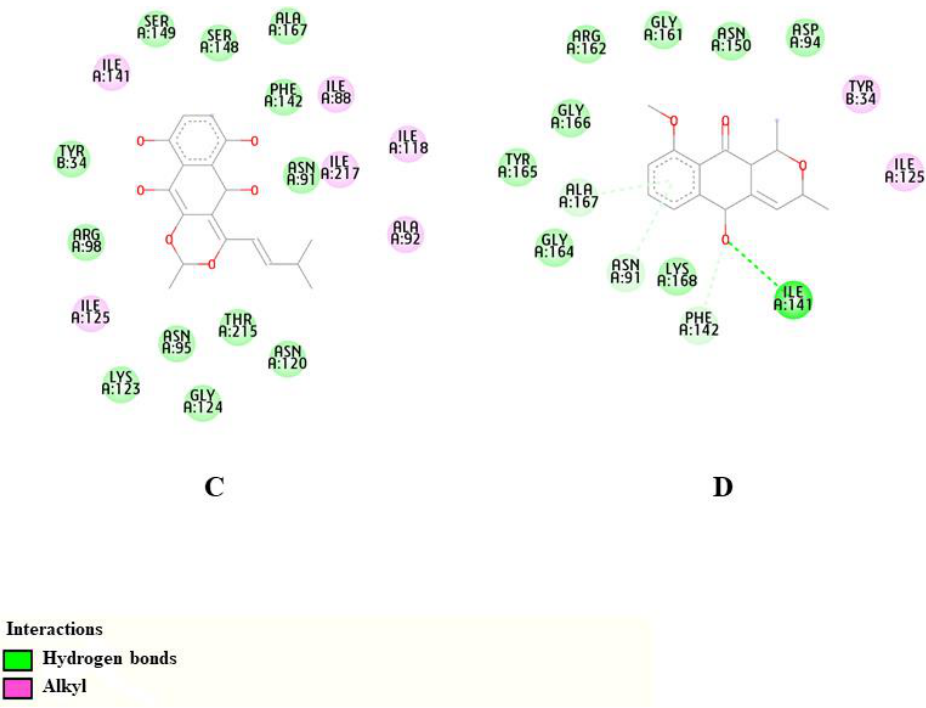
Figure 2. The 2D representations of intramolecular interactions of compounds CP13 ( A ), CP14 ( B ), CP17 ( C ) and Isoeleutherin ( D ) with Topoisomerase